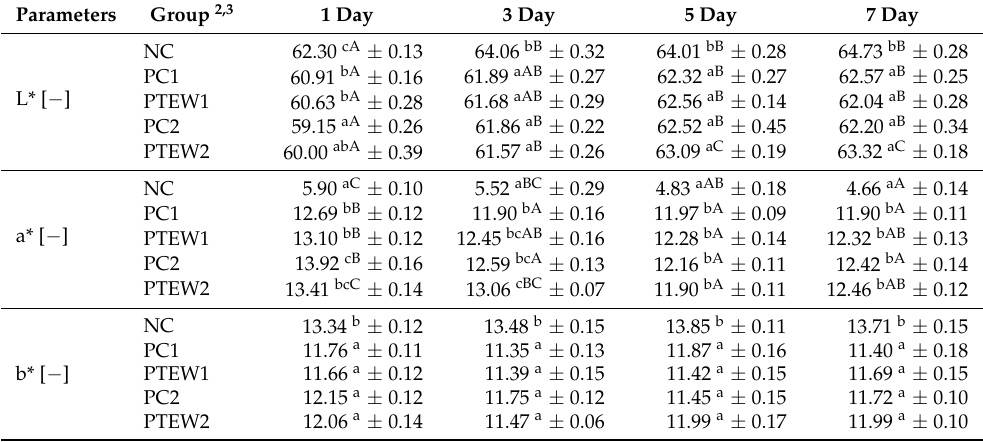
Table 4. The effect of plasma-treated egg whites on color parameters (mean ± SE 1 ) of liver p â t é s during